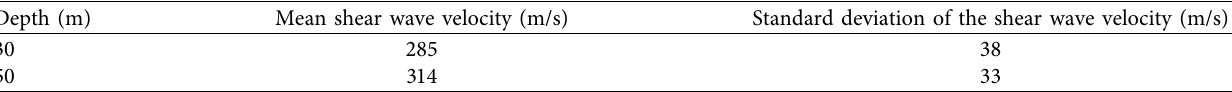
Table 4: Mean and standard deviation of the shear wave velocities in the upper 30m and 50 m of soil deposits. Depth (m) Mean shear wave velocity (m/s) Standard deviation of the shear wave velocity (m/s) 30 285 38 50 314